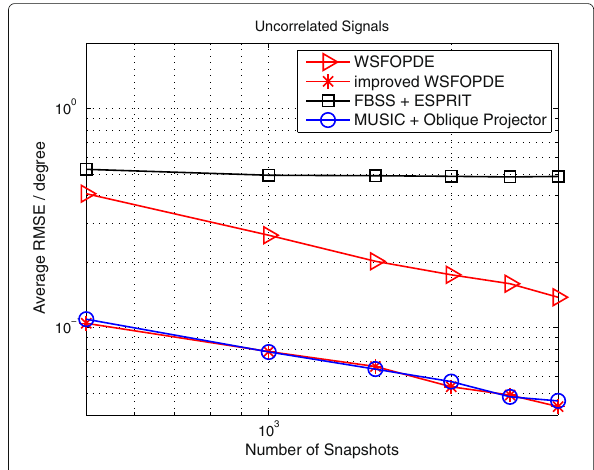
Fig. 3 The DOA-DOD estimation performance versus the number of snapshots: uncorrelated signals